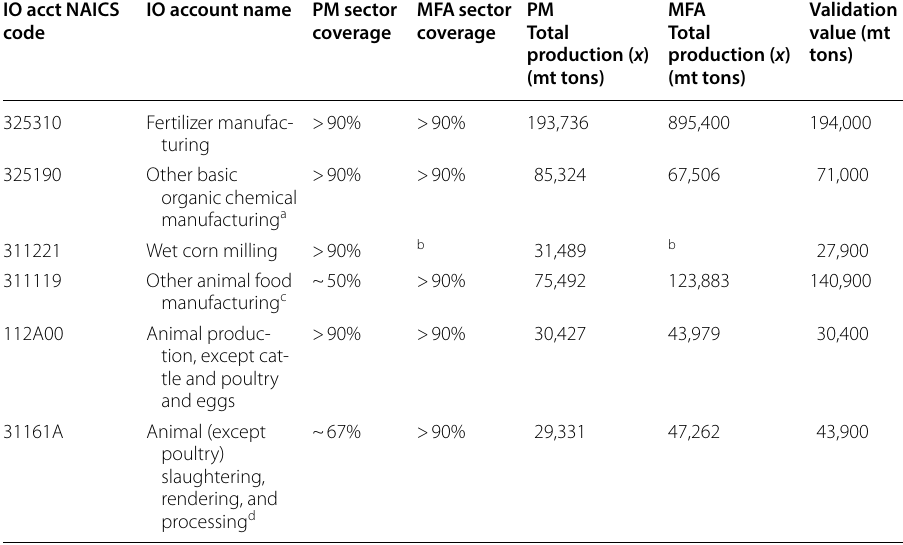
Table 5 Mapping of models to IO sectors with approximate coverage along with total production ( x ) numbers from the process modeling approach (PM) as well as the approach in Singh et al. (2017)